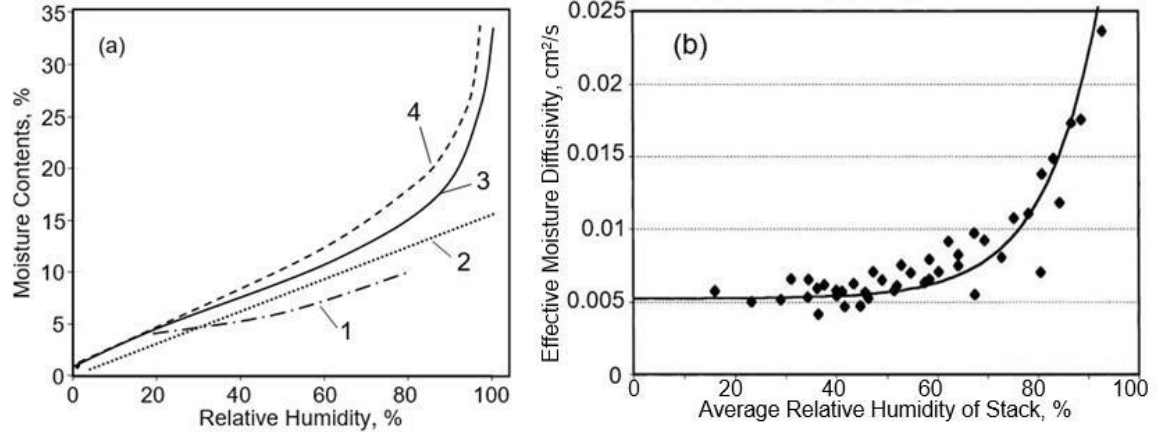
Figure 7. ( a ) Moisture content in 160 g/m 2 paper in dependence on RH. 1 — Data extracted from [234], 2 — [235]; 3 — [236]; 4 — [237]; ( b ) Effective moisture diffusivity of bleached kraft paperboard (BKP) at 23.9 °C and atmospheric pressure. Adapted with permission from [224]. Copyright 2003: ACS.